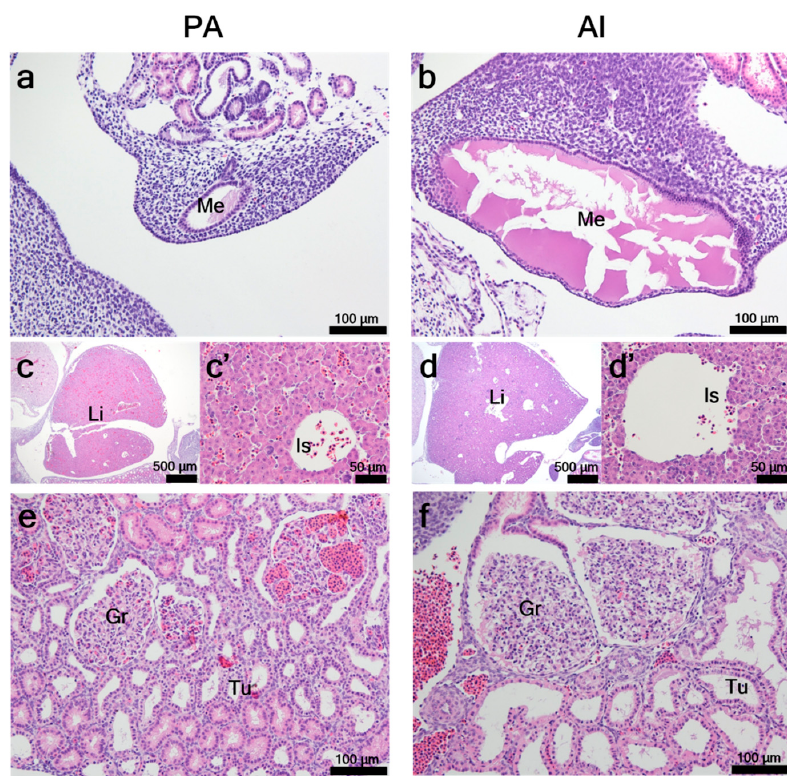
Figure 3. Histopathological analysis of PA and AI embryos at day 26. Histopathological examinations of developing mesonephric ducts ( a , b ), livers ( c , d ), and kidneys ( e , f ) were conducted on PA and AI embryos at day 26 after embryo transfer. Me: mesonephric duct; Li: liver; Is: liver island; Gr: glomerulus; Tu: mesonephric tubules.